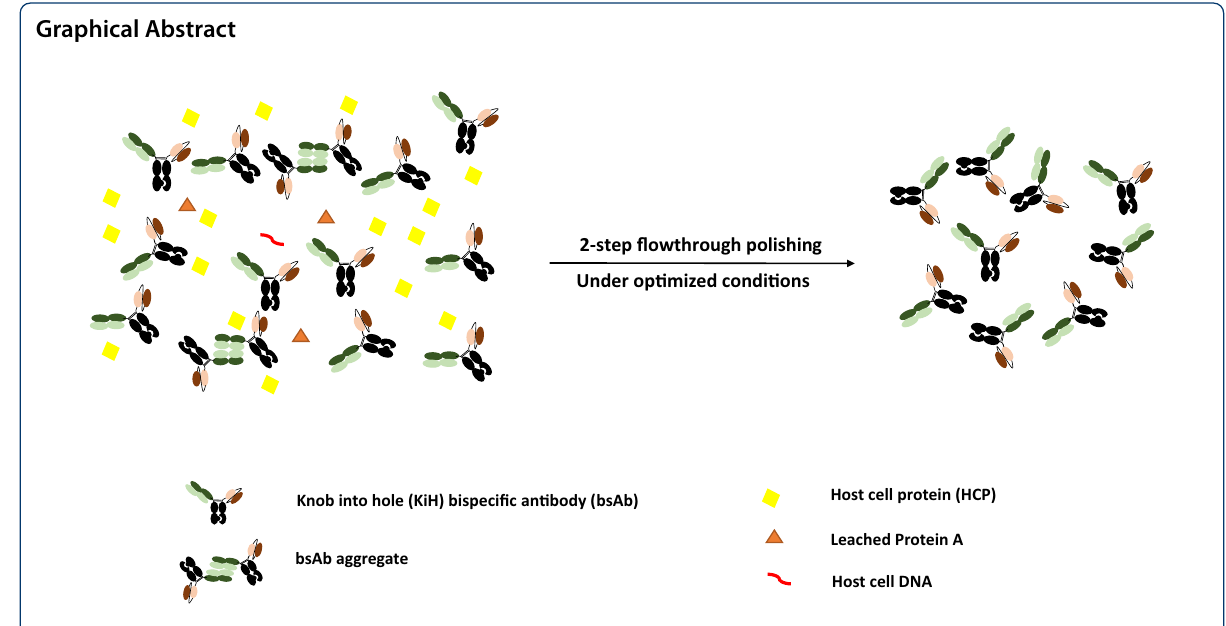
2-step flowthrough